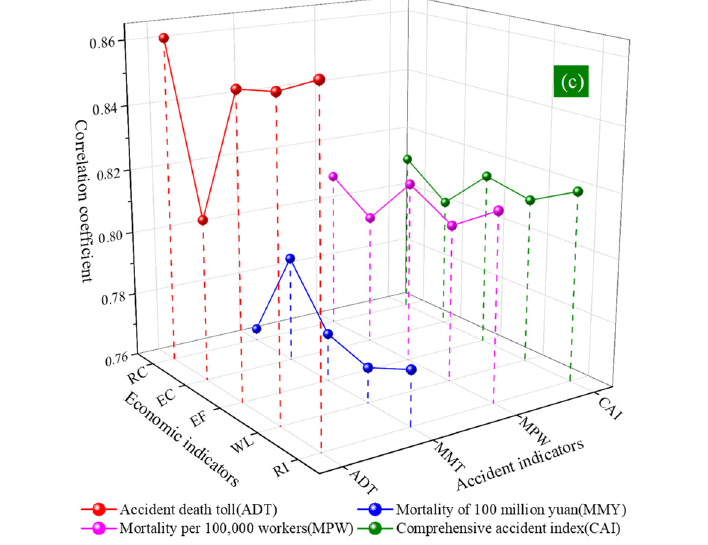
Figure 6. Different correlation coefficients between accident indicators and economic indicators.